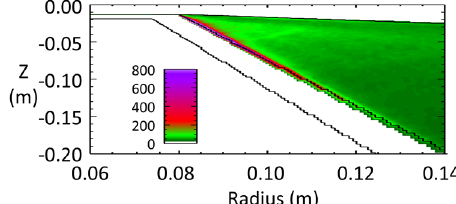
FIG. 23. The location and the pattern of anode temperature rise to > 400 °C of blocks 1 and 2 in the CSMITL simulation are shown.